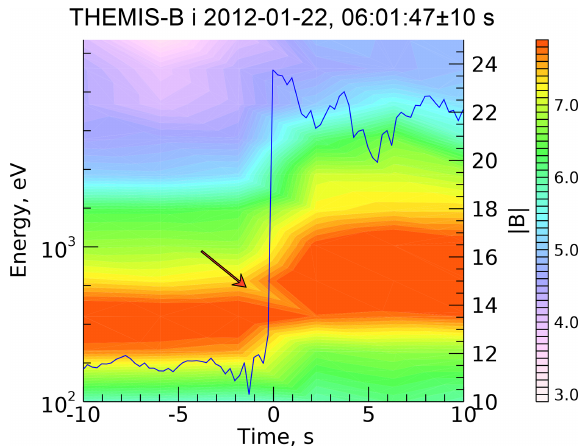
Figure 11. Magnetic profile of the 28 November 2011 THEMIS-C- measured shock with the gap in spectrogram due to reflected